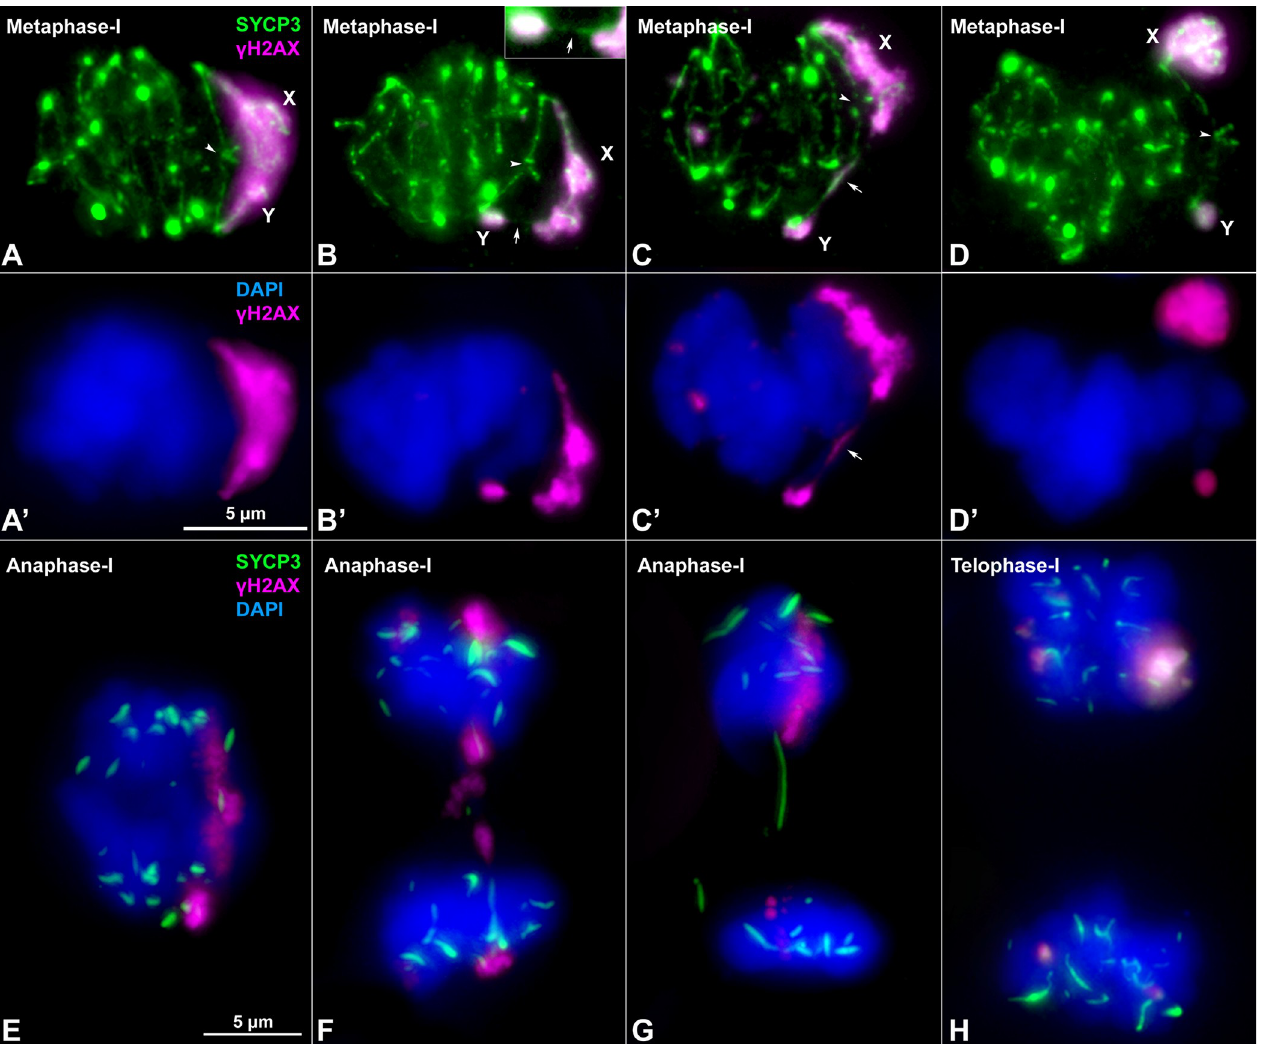
Fig 5. Sex chromosome segregation. Squashed spermatocytes labelled with antibodies against SYCP3 (green) and γ H2AX (magenta) and counterstained with DAPI (blue). Non-homologous segments of the sex chromosomes (X, Y) are indicated. A-D’ . Metaphase-I. Different configurations of the sex bivalent can be observed. The neo-PAR always shows a chiasma (arrowheads), however, the non-homologous segments can be associated with each other by forming a common chromatin mass ( A-A’ ), or through a SYCP3-positive filament (arrow) (see enlarged detail on the top) ( B-B’ ) or a γ H2AX-positive filament (arrow) ( C-C’ ). Alternatively, these segments can appear completely separated ( D-D’ ). E-G . Anaphase-I. γ H2AX connections ( E ) and/or SYCP3 ( F , G ) filaments are observed between segregating chromosomes during early anaphase, resembling the associations observed at metaphase-I. At telophase-I ( H ), no lagging or mis-segregated chromosomes are